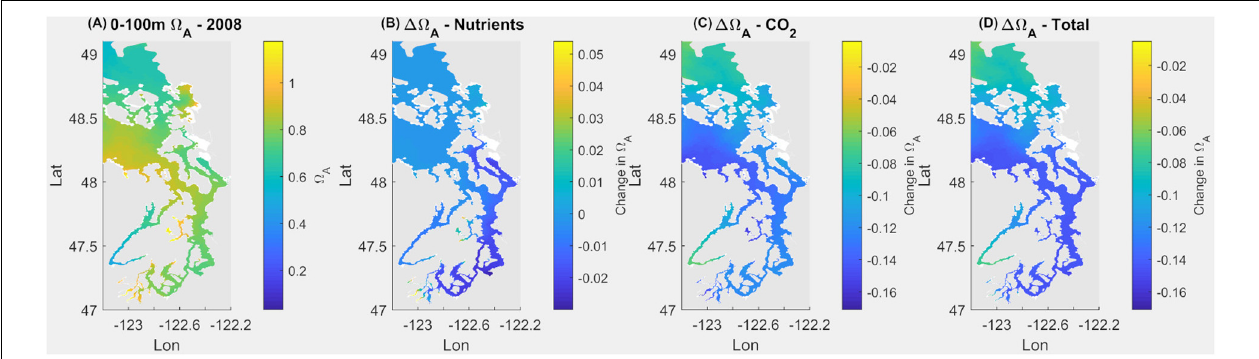
FIGURE 2 | Current omega saturation state ( (cid:127) ar ) averaged over 100 m in the Salish Sea (A) , with the changes in (cid:127) ar due to nutrients (B) , atmospheric CO 2 (C) , and a combination of both (D) .